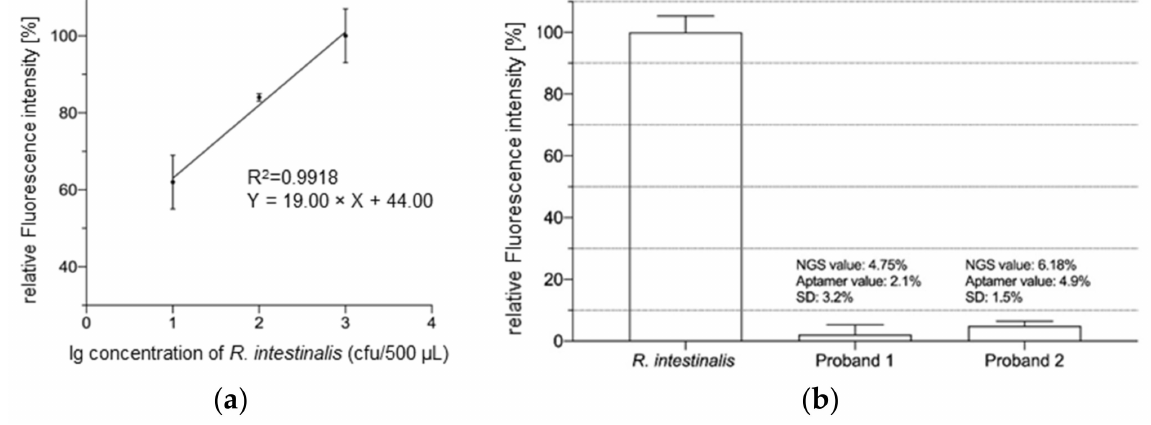
Figure 4. ( a ) Sensitivity determination of aptamer library Ri 7_2. In a 500 µ L reaction system containing 5 pmol aptamer library Ri 7_2, the relative fluorescence intensity showed a positive correlation with the cell number when the number of R. intestinalis varied within 10–10 3 CFU. A clear positive correlation was observed (R 2 = 0.9918), while the detection limit of the aptamer library was 10 CFU at this time; ( b ) Roseburia abundance in fecal samples based on the aptamer library Ri 7_2 and 16s rRNA NGS (see Tables S2 and S3, Supplementary Materials). The “NGS value” represents the actual Roseburia content in fecal bacteria as determined by NGS. The “Aptamer-value” shows the Roseburia abundance in fecal bacteria as determined by the aptamer library Ri 7_2. The SD represents the standard deviation during the measurement of the target